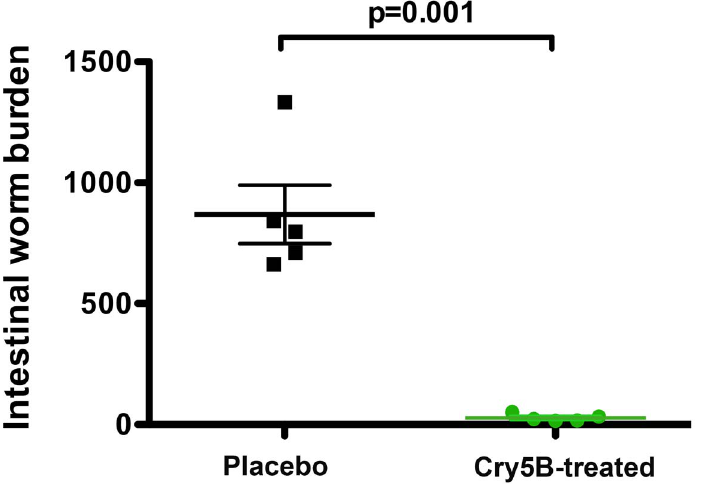
Figure 4. Cry5B effects a near complete cure of Ascarissuum infection in pigs. Shown are the fourth-stage larval burdens of individual pigs treated with HD1 spore lysate (placebo; parent strain without Cry5B-expressing plasmid) and HD1 + Cry5B spore-crystal lysate (Cry5B-treated; parent strain with Cry5B-expressing plasmid). The actual worm burden means with standard error of the means are, respectively, 868.6 6 120 and 27.6 6 6.4.